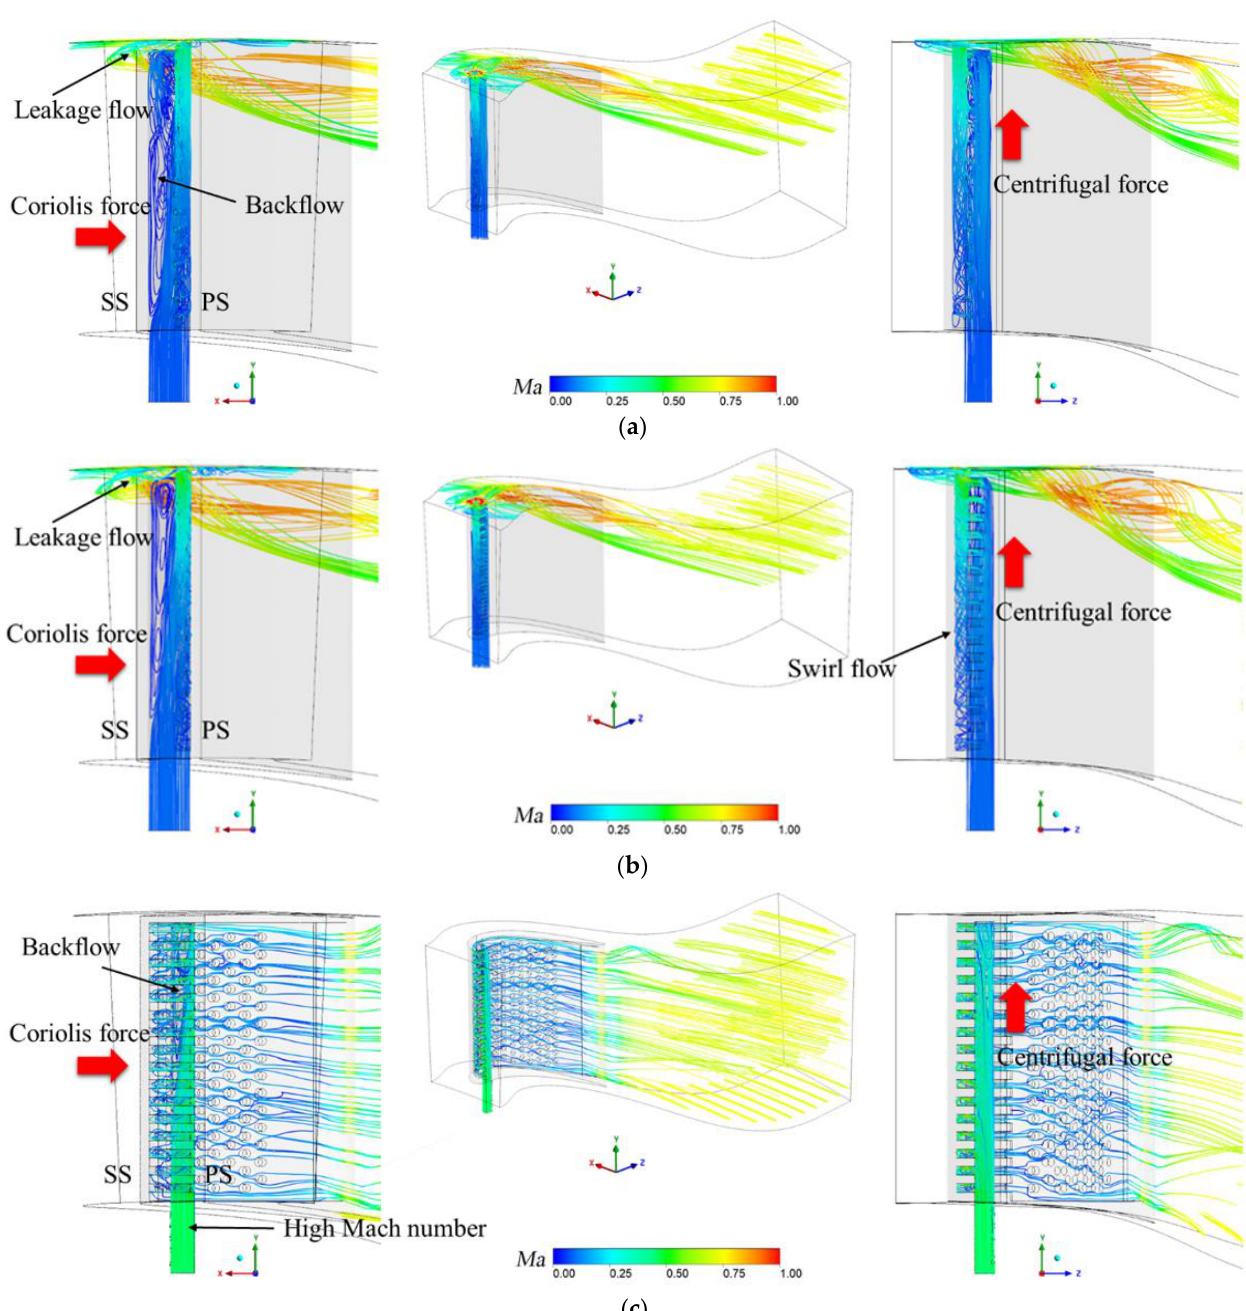
Figure 15. Streamline comparison between different internal cooling structures ( Re j = 20,000); ( a ) Impingement cooling; ( b ) Swirl cooling; ( c ) Wall jet impingement cooling.